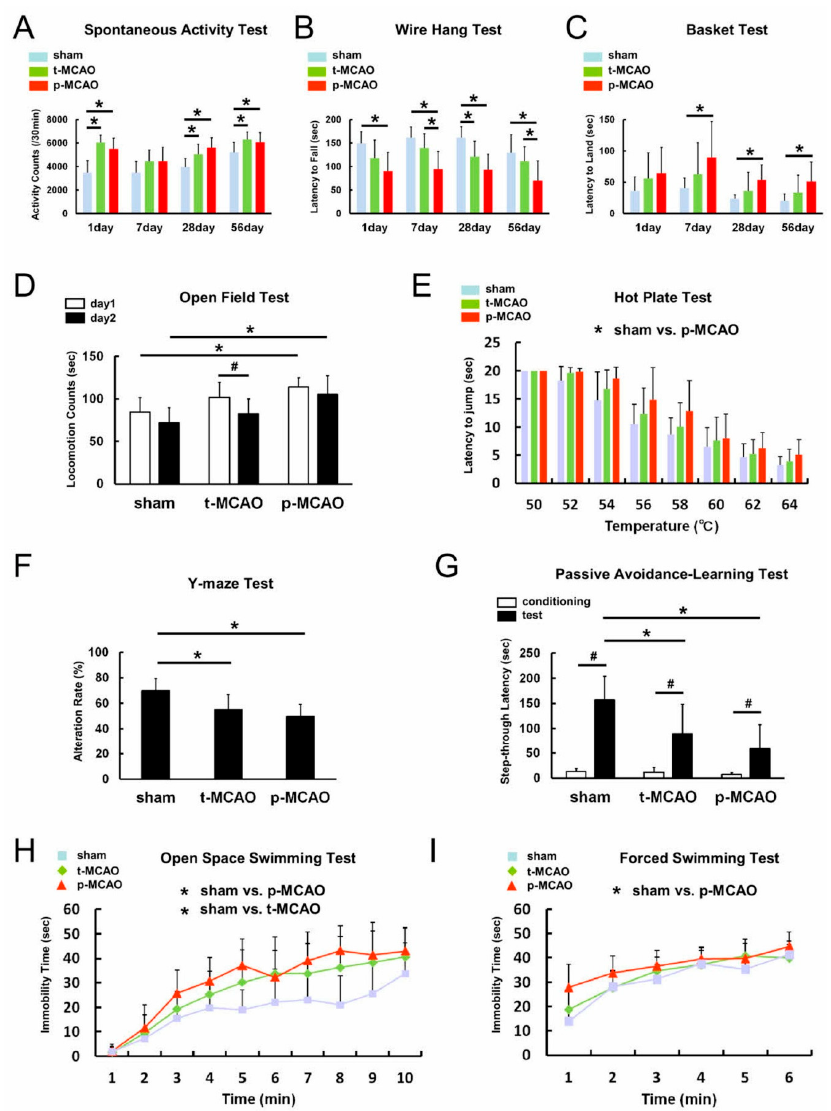
Figure 7. The spontaneous activity ( A ), wire hang ( B ), and basket ( C ) tests were performed 1, 7, 28, and 56 d post stroke. The open-field ( D ), hot plate ( E ), Y-maze ( F ), passive avoidance learning ( G ), open space swimming ( H ), and forced swimming ( I ) tests were performed 56 d post stroke. * p < 0.05 between groups (sham-operation vs 90-min t-MCAO, sham-operation vs. p-MCAO, or 90-min t-MCAO vs. p-MCAO), within day ( A – I ). # p < 0.05 between days 1 and 2 ( D ). # p < 0.05 between conditioning and test days ( G ). ( n = 12 for sham, n = 16 for t-MCAO, n = 11 for p-MCAO). Abbreviations: p-MCAO, permanent middle artery occlusion; t-MCAO, transient middle cerebral artery